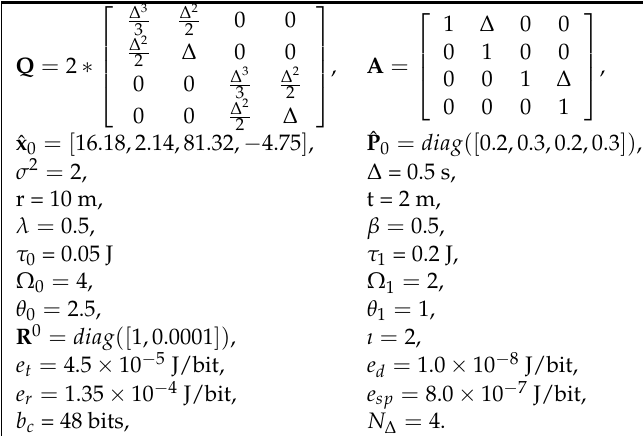
Tracking errors . As shown with the red dotted line in Figure 6, a maneuvering target move along a curve trajectory in the monitored area which is assumed to be covered by N s uniformly distributed SNs. One of the estimated target trajectories is displayed with green solid